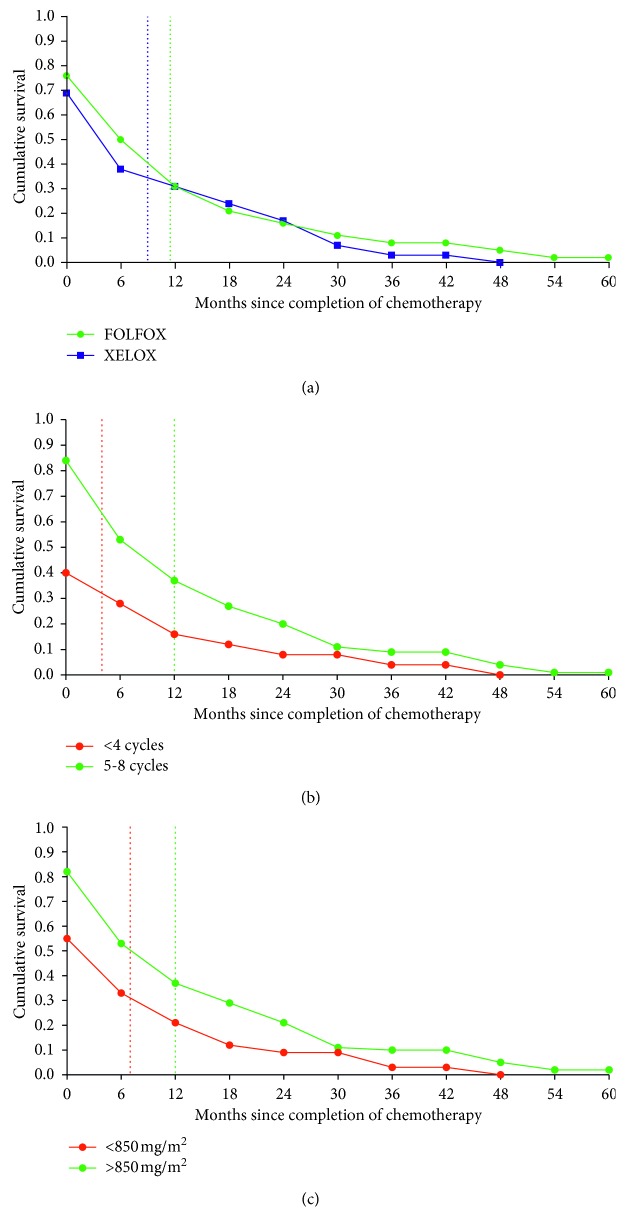
Cumulative probability of patient survival by (a) regimen, (b) cycles covered, and (c) cumulative dose received in the South Western Sydney between 2011 and 2015. Patients who received FOLFOX survived longer compared to XELOX (median value: 11.5 months vs. 9 months; n = 211 vs. n = 105, respectively). The vertical dotted lines indicate median survival time for each group.